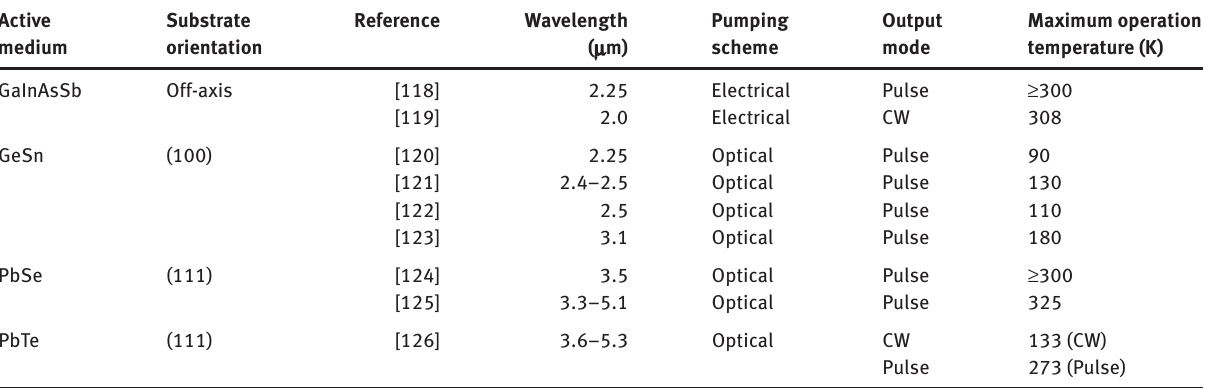
Table 3: Mid-IR laser structures monolithically grown on Si via heteroepitaxy. Active medium